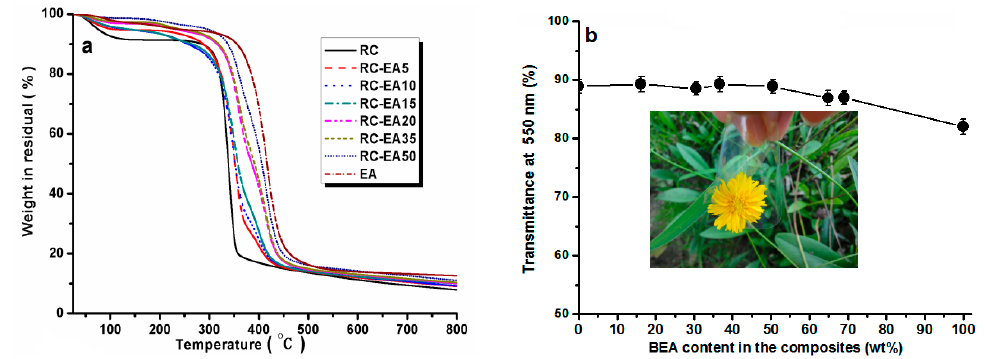
Figure 5. Thermal analysis of the RC, BEA, and composite films with different resin content ( a ); and optical transmittance at 550 nm of the RC, BEA, and composite films ( b ); the insert was the photo of the RCBEA35.